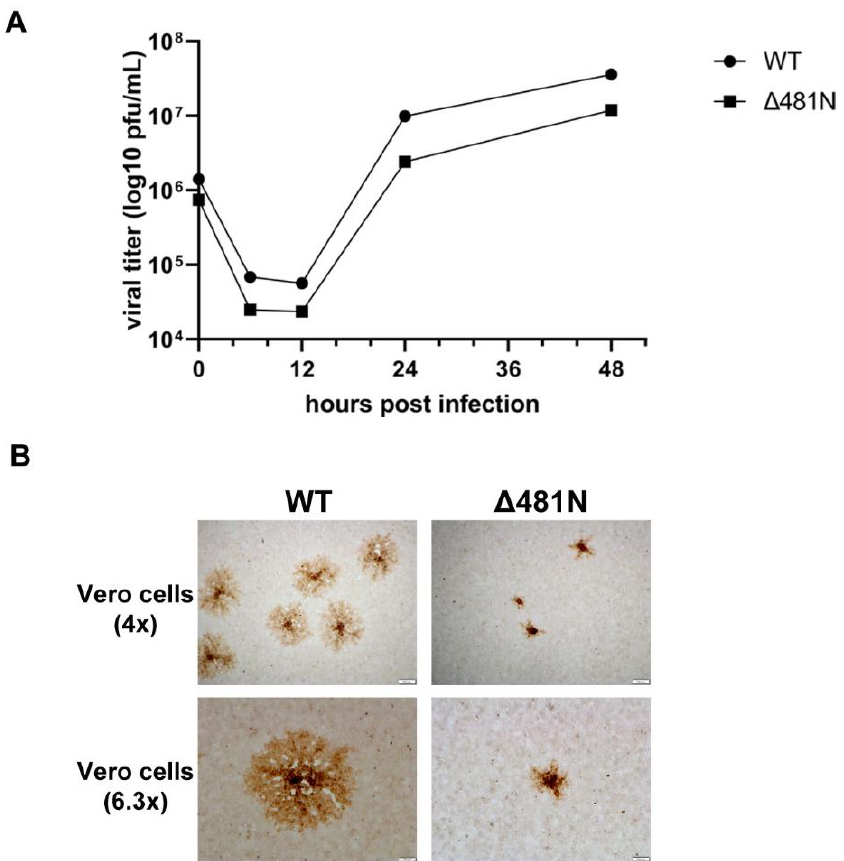
Figure 6. Viral replication kinetics and plaque morphology of wildtype and ∆ 481N mutant virus. ( A ) Viral replication curve. Viral replication curve of ∆ 481N mutant virus shows similar growth kinetics to wildtype. ( B ) Plaque morphology. Significant smaller plaque formation in ∆ 481N mutant virus as compared to wildtype.